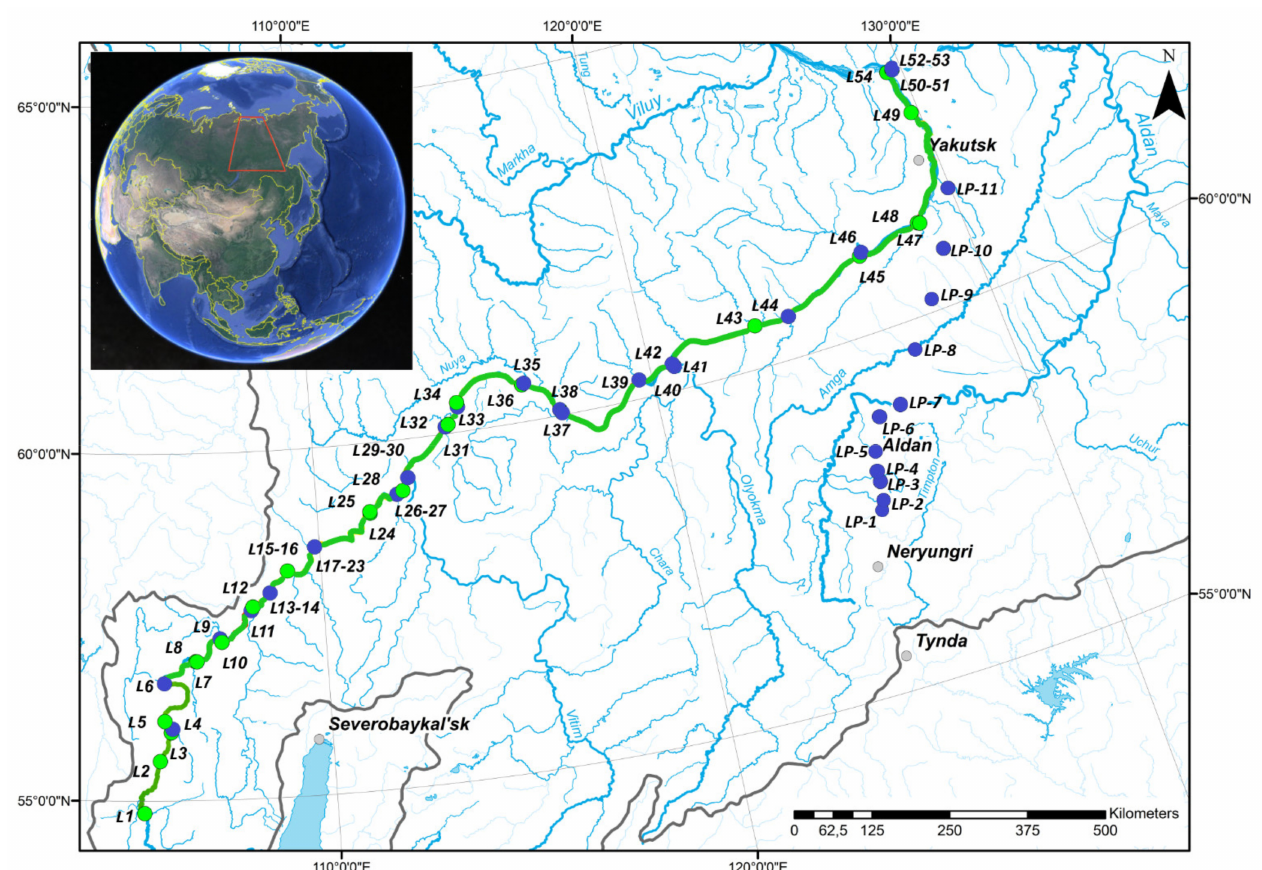
Figure 1. Map of the studied part of the Lena River basin with sampling points of the main stem (green circles) and tributaries (blue circles). The positions of tributaries are shown in Figure S1. See Table S1 for tributaries and river watersheds (LP)